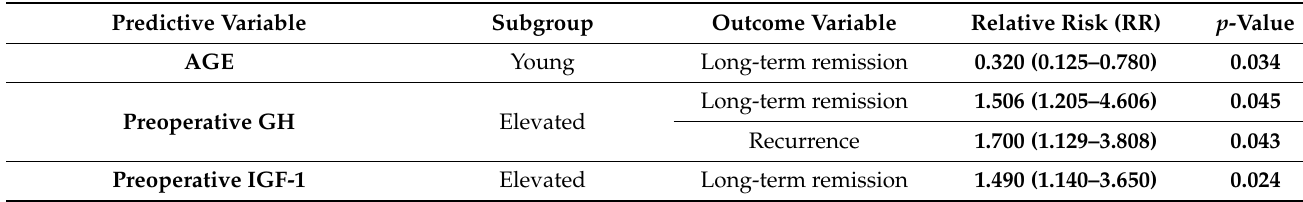
Table 4. Multivariate analysis is presented. Each subgroup of the predictive variable analyzed is presented according to its statistically significant relation to the outcome variables (remission, recurrence, and reintervention) through Relative Risk and p